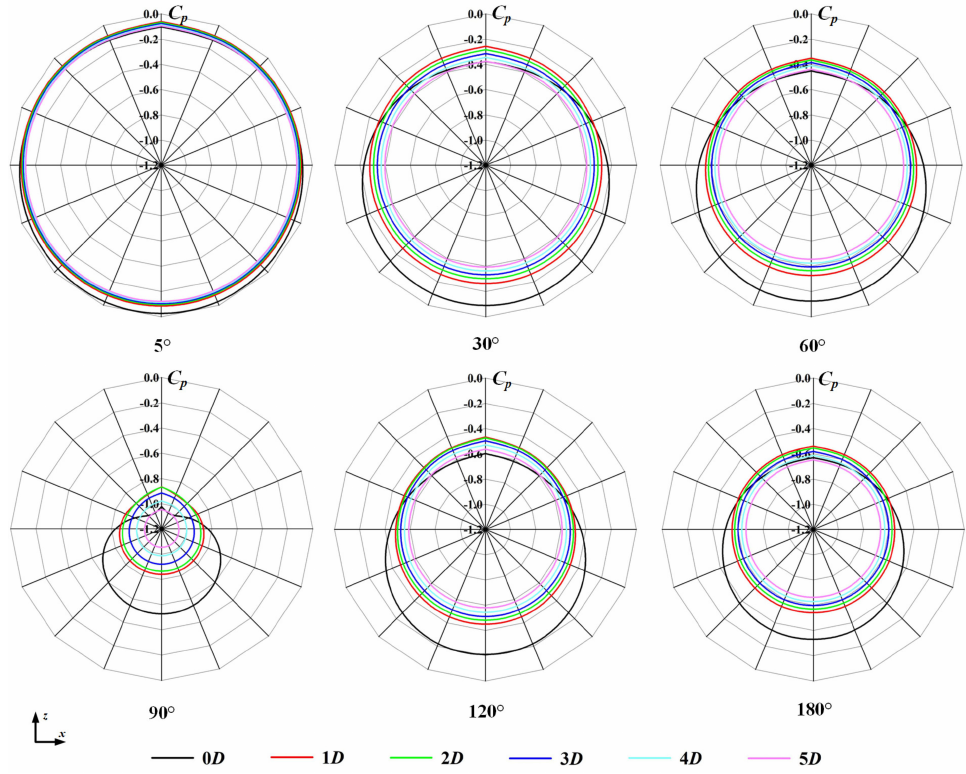
Figure 6. Pressure distribution on the downstream cross − section of the bend pipe with different bending